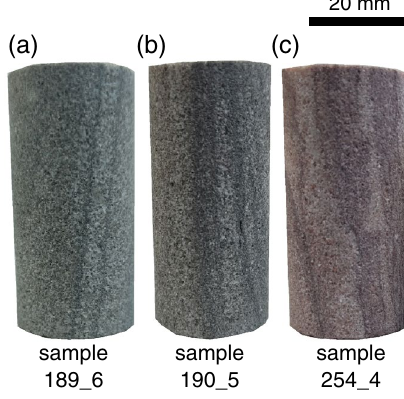
Fig. 13 Photographs of three of the measured 20-mm-diameter cylindrical core samples (samples 189_6, 190_5, and 254_4) that show laminations that are sub-parallel or oblique to the core